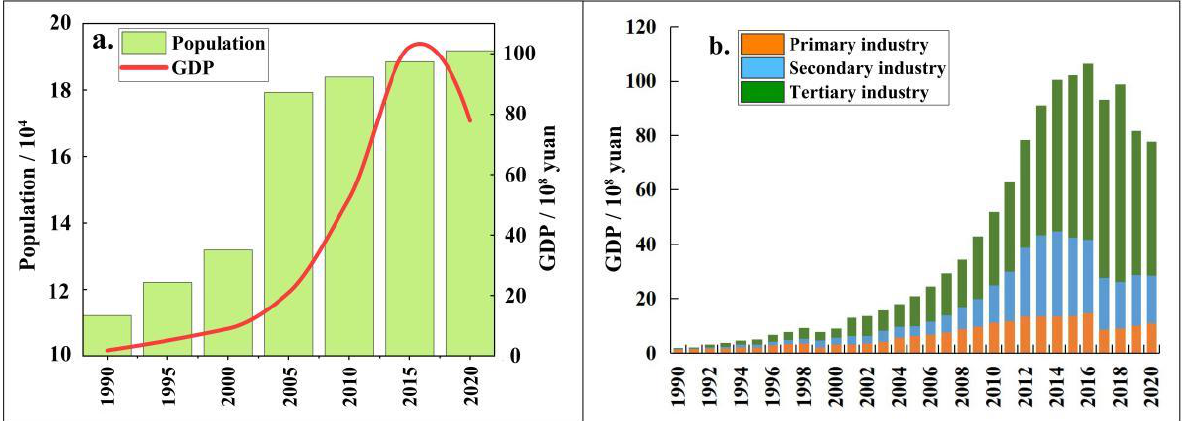
Figure 8. Social economic dynamics of Dunhuang Oasis, changes in population and GDP of Dunhuang from 1990 to 2020 ( a ), changes in economic structure of Dunhuang from 1990 to 2020 ( b ).